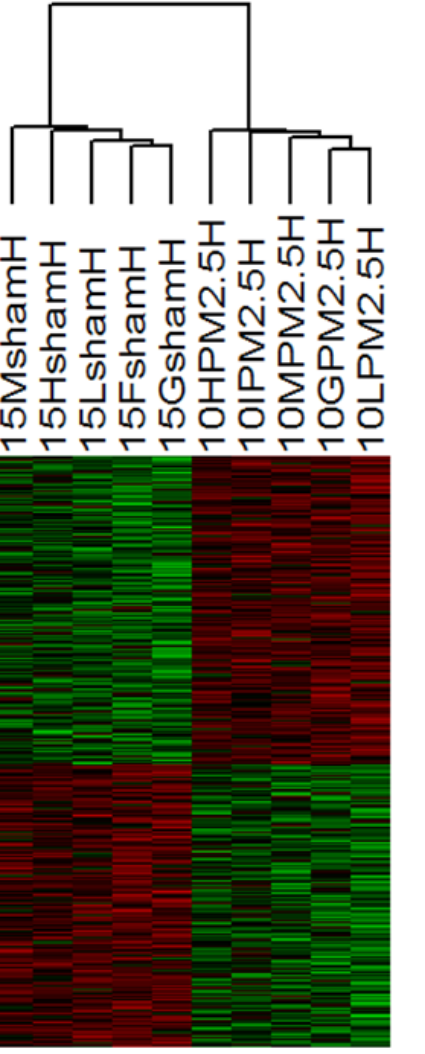
Figure 5. Hierarchical cluster analyses of differentially ex- pressed genes in heart. Hierarchical cluster analyses of 359 DEG between PM2.5win-treated heart (n=5) and sham (n=5) mice using dChip software. Each column represents a mouse and each row represents a gene. Red color indicates genes that were up-regulated and green color indicates genes that were down-regulated.